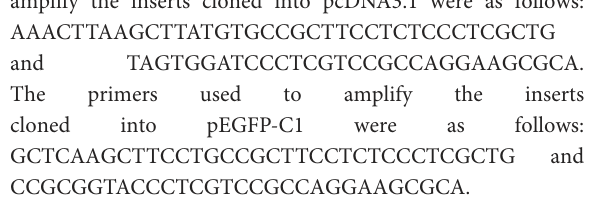
into the pcDNA3.1 and pEGFP-C1 vectors with multiple cloning sites. The mini-gene constructs were then transfected into HeLa and 293T cells separately using Lipofectamine